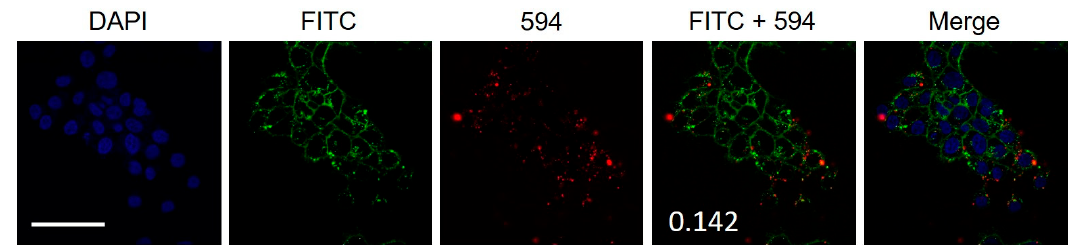
Figure 2. Confocal microscopy images of FaDu cells incubated for 20 min with FL8V1 (10 µ M) at 37 ◦ C and Jam-A/Alexa Fluor 594; bar represents 50 µ m; number indicates Pearson’s correlation coefficient.